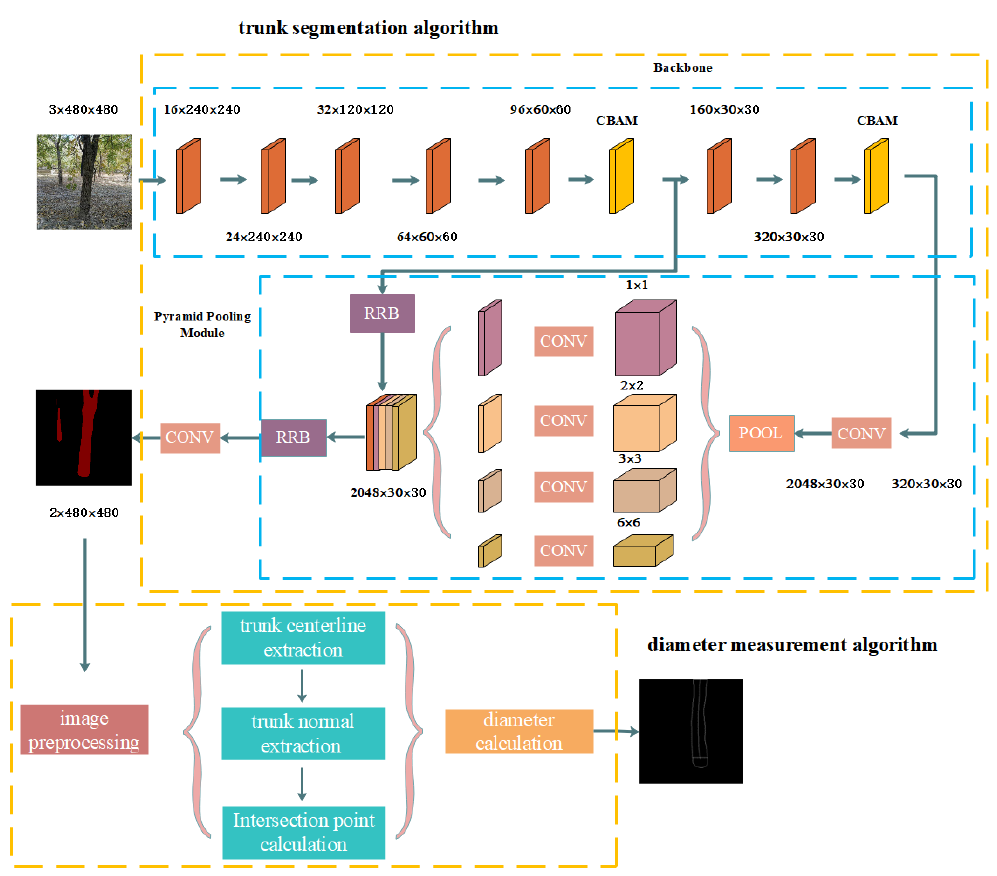
Figure 10. Flow chart of jujube tree diameter measurement method, based on centerline.